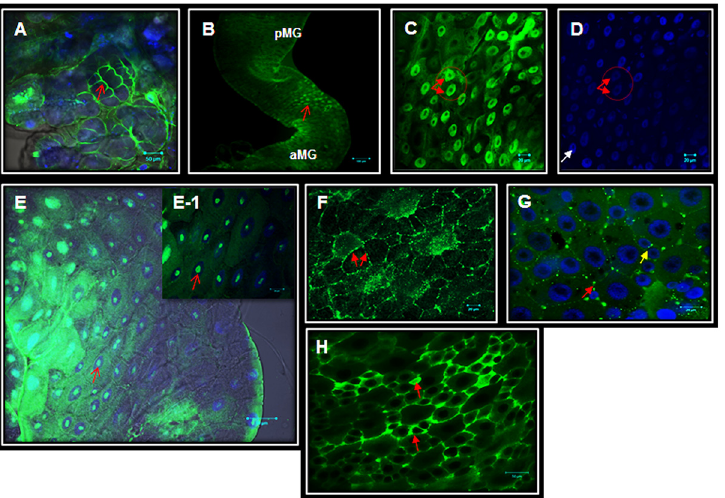
arrow). Scale bars ( μ M) are included in each